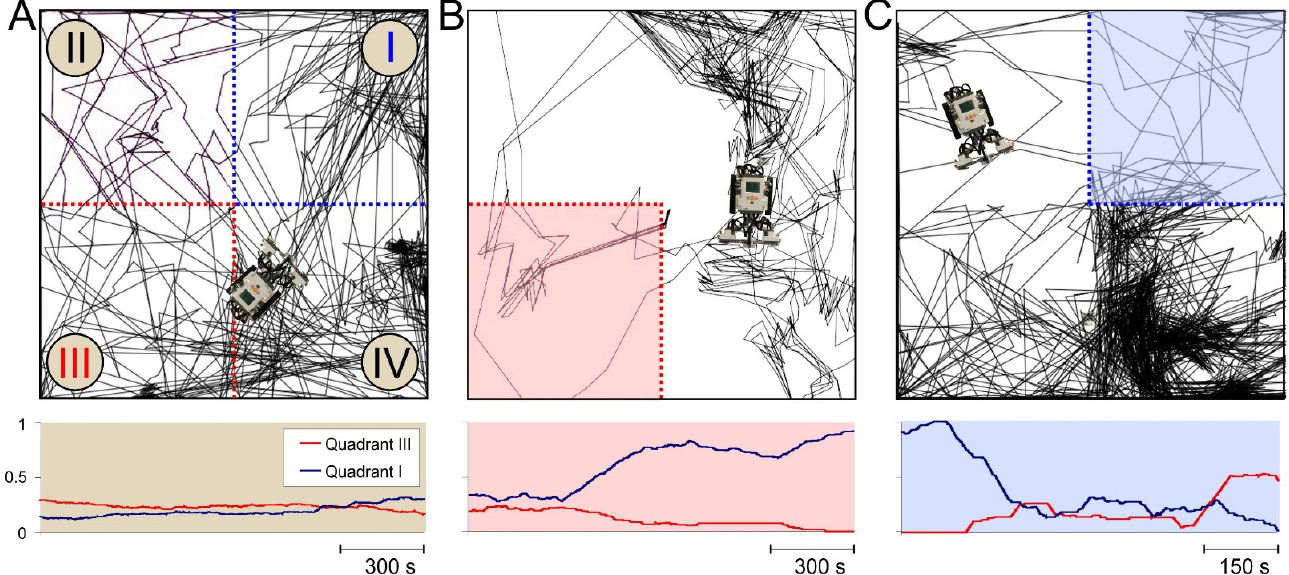
Figure 7. Adapting the robot behavior to changing environment. ( A ) Top: Traces of the robot movements in the arena without dangerous zones (all four quadrants are safe). The robot randomly explored the environment. Bottom: Moving average of the time spent by the robot in quadrants I (blue curve) and III (red curve). ( B ) Same as in ( A ) but during movement in the arena with the danger zone in quadrant III. The robot spent little time in the dangerous quadrant (red curve), while the time spent in quadrant I rose (blue curve). ( C ) Same as in ( B ) but during relearning. The dangerous zone had moved from quadrant III to I. The robot learned the new dangerous area and recovered the previous one that was now safe. The times spent by the robot in quadrants I and III were inverted (the blue curve decayed, while the red one increased).